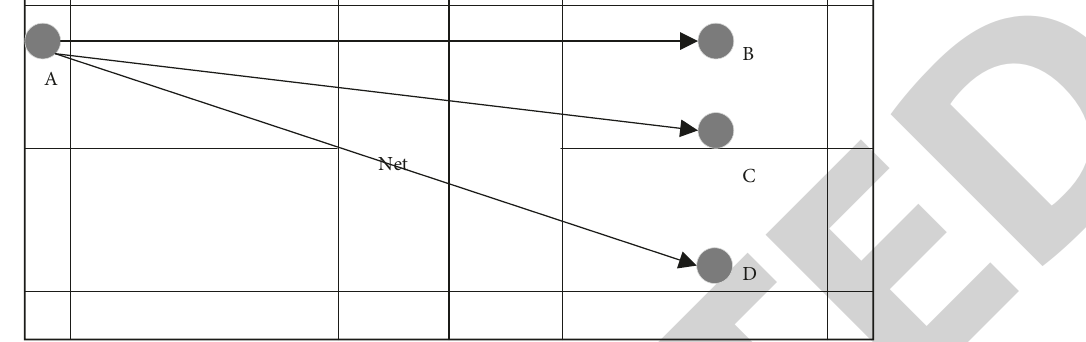
Figure 1: Location node distribution of the badminton backcourt stroke.